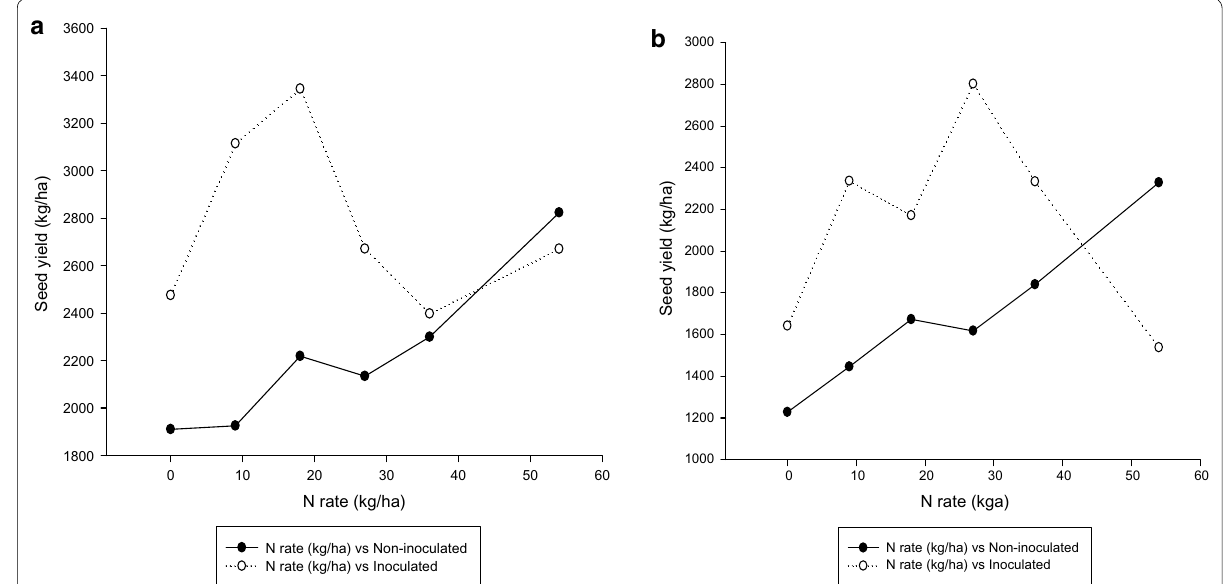
Fig. 2 Interaction effect of N rate and Rhizobial inoculation on seed yield of soybean for 2016/17 ( a ) and 2017/18 ( b ) cropping seasons over two